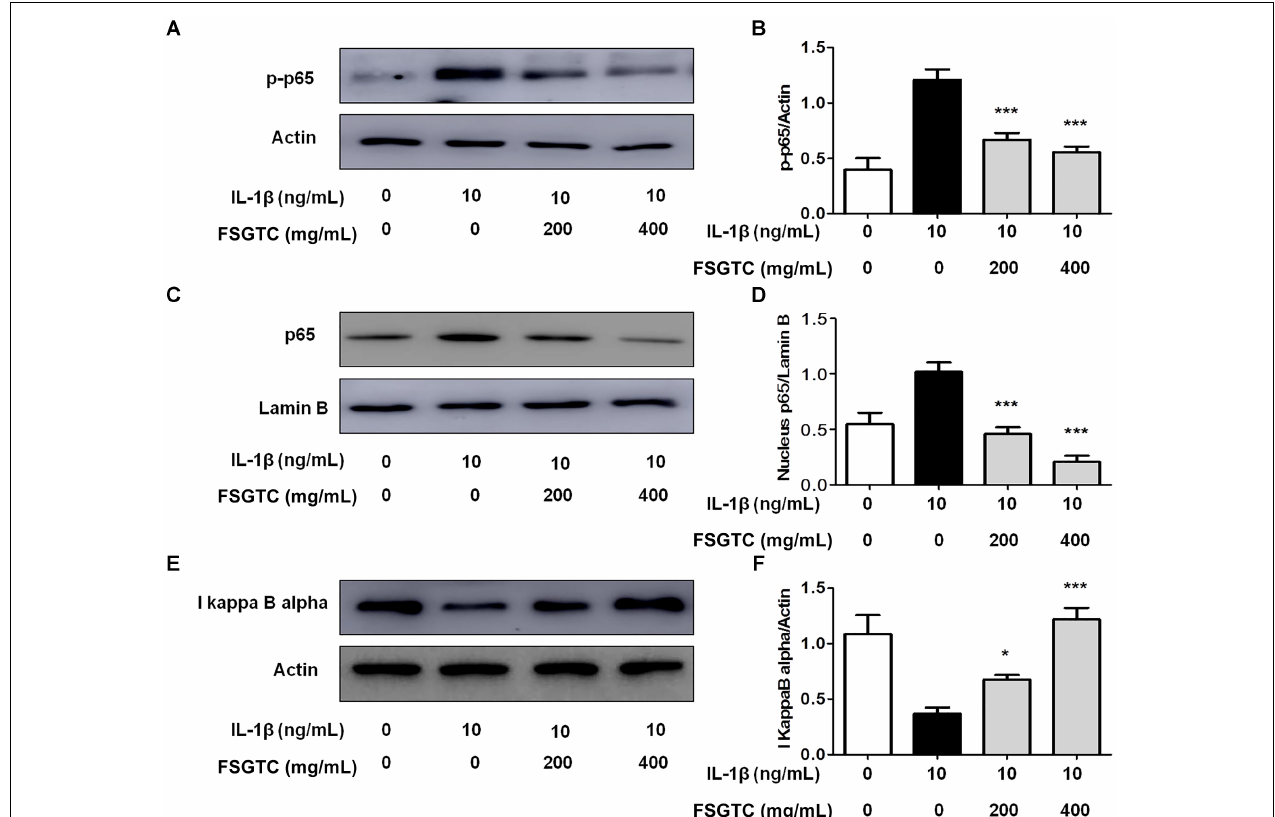
FIGURE 6 | Effects of FSGTC on IL-1 β -induced activation of NF- κ B in SW982 cells. The cells were treated with various doses (200 and 400 mg/mL) of FSGTC. Lysates were prepared and Western blot performed using specific phospho-p65 antibodies (A) , NF- κ B p65 (C) , and I κ B α (E) . Histogram analysis for the expression levels of phospho-p65 (B) , nucleus p65 (D) , and I κ B α (F) as described above. Actin and lamin B were used as internal controls. n = 3, x ± s . ∗ p < 0.05; ∗∗ p < 0.01, ∗∗∗ p < 0.001 vs. IL-1 β without